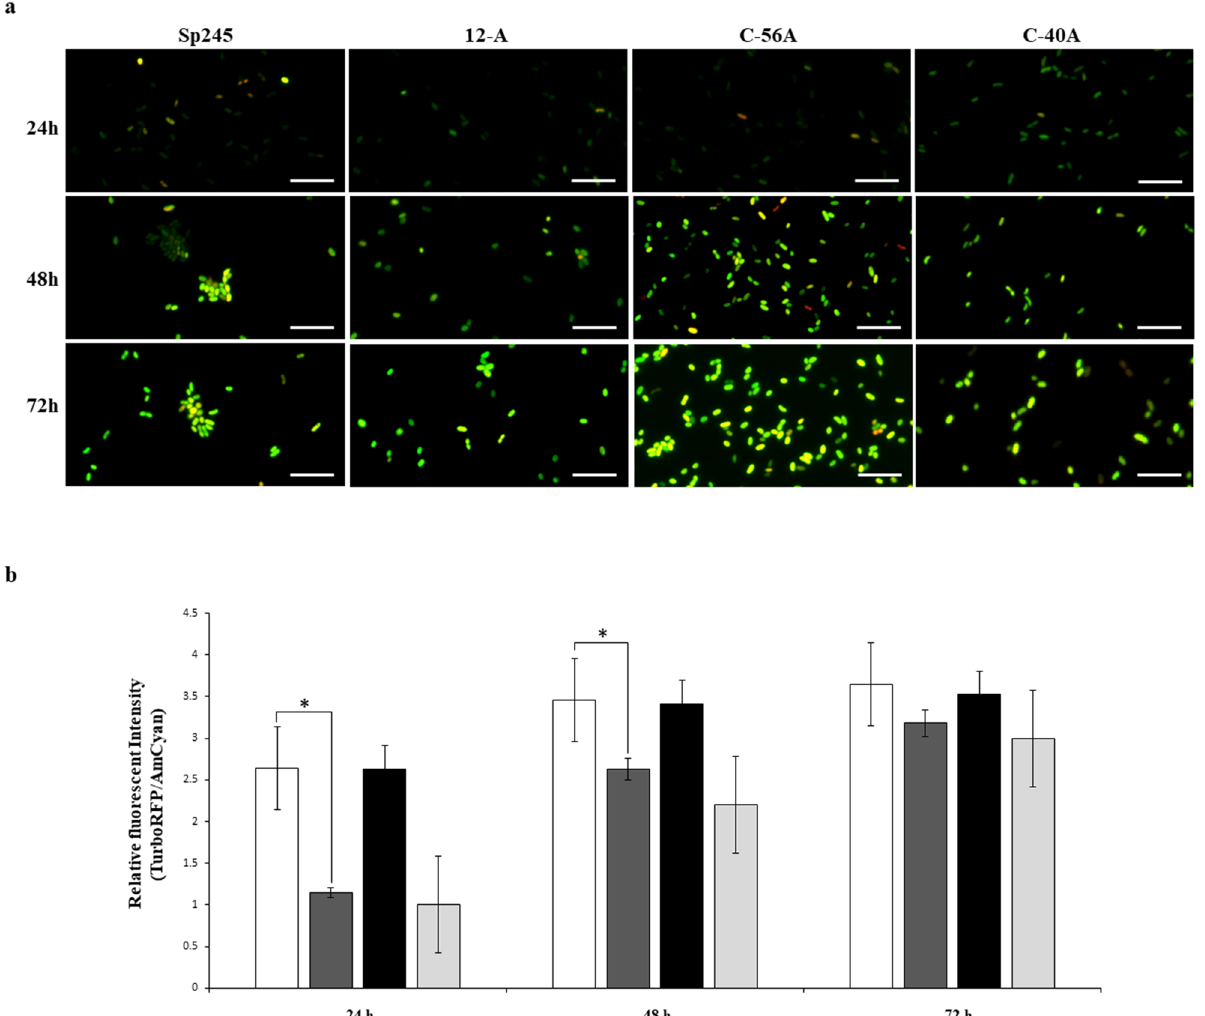
Figure 4. Determination of cyclic-di-GMP levels using a riboswitch biosensor. ( a ) The A. brasilense Sp245 , A. brasilense 12-A , and A. brasilense C-56A , and C-40A strains containing the c-di-GMP biosensor (pFY4535) were grown in NFB* + KNO 3 broth containing 30 μg/mL Gm with incubation for 24, 48, or 72 h at 30 °C. Then, Azospirillum cells were attached to the surface of a coverslip and sealed with a 1% agar plug. Cell images were collected at these time points after inoculation using a Nikon TE2000U microscope equipped with a 100× objective (oil immersion objective). Merge images represented the overlay of the fluorescence images AmCyan green, TurboRFP red and both yellow. ( b ) RFI represents the ratio between the TurboRFP and AmCyan fluorescence intensities and is directly proportional to c-di-GMP levels, as analysed using ImageJ software 35 . The RFI values represent the standard deviations of three biological replicates, and significant differences are indicated at * P < 0.05 according to Student’s t-test by SigmaPlot (Systat Software, San Jose, CA). The bar corresponds to 10 out the vector empty and complemented mutant (C-56A) strains using a fluorescent c-di-GMP reporter. This analysis was performed by quantifying the riboswitch fluorescence intensity, which was directly proportional to the c-di-GMP levels 34 . As expected, a low c-di-GMP level was determined in the 12-A mutant compared with the wild-type strain; an approximately 61% or 24% reduction in c-di-GMP levels was observed in the 12-A mutant strain compared with WT cultures at 24 h or 48 h, respectively, which was fully recovered in the complemented mutant. However, there was no significant difference in intracellular c-di-GMP levels compared with the WT strain in the cells after 72 h of growth, potentially due to compensatory effects of other DGCs occurring in the genome of the A. brasilense WT strain. In accordance with the data regarding biofilm and EPSs component production from the CR assay, the mutation reduced the levels of c-di-GMP in cells growing in NFB* + KNO 3 medium. These data indicate that overexpression of CdgD allows a temporary intracellular second messenger levels in A. brasilense (Fig. 4). Although bioinformatic analysis showed that all amino acid motifs were conserved in the EAL domain, the phenotyping studies were unable to show that CdgD functioned as a PDE protein.